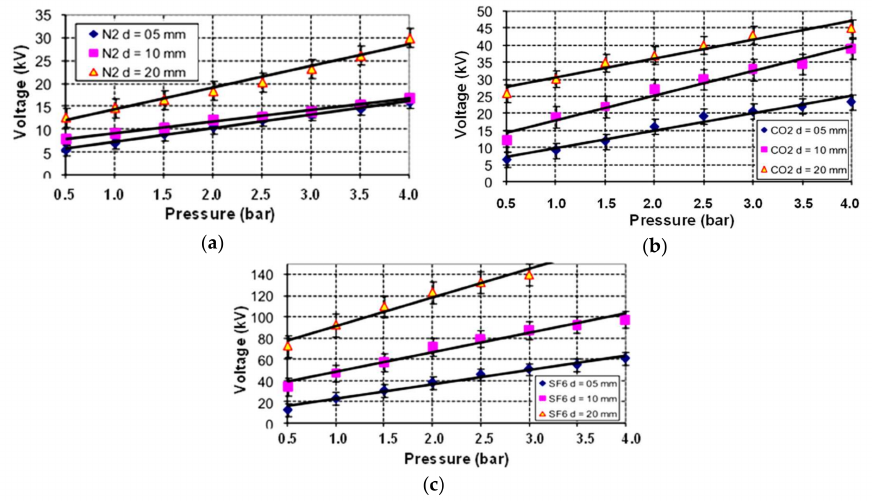
Figure 2. AC breakdown voltage of N 2 ( a ), CO 2 ( b ) and SF 6 ( c ) gases in the point–plane electrode arrangement.